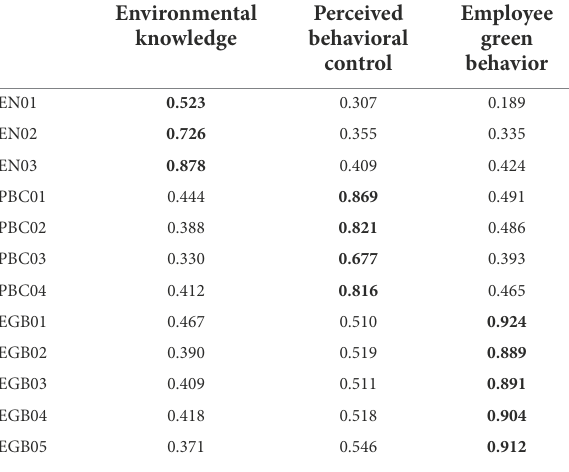
TABLE 5 Cross-loading analysis.